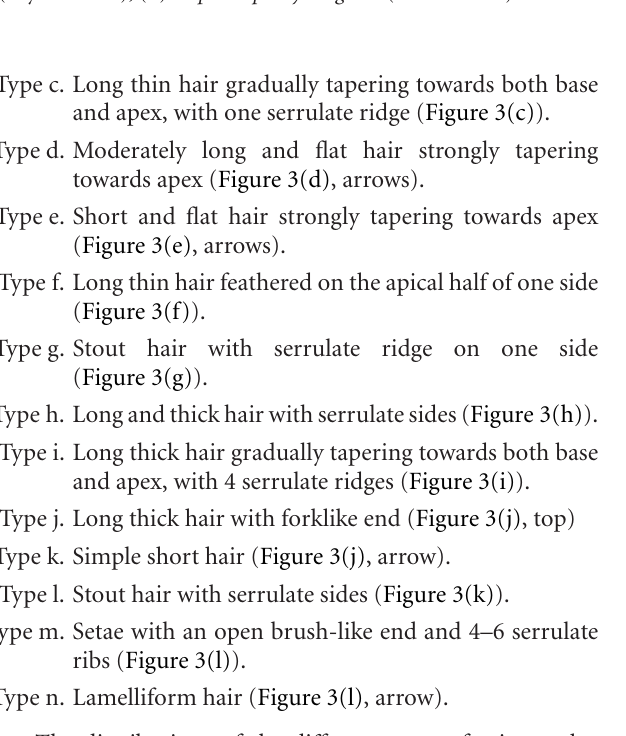
Type c. Long thin hair gradually tapering towards both base and apex, with one serrulate ridge (Figure